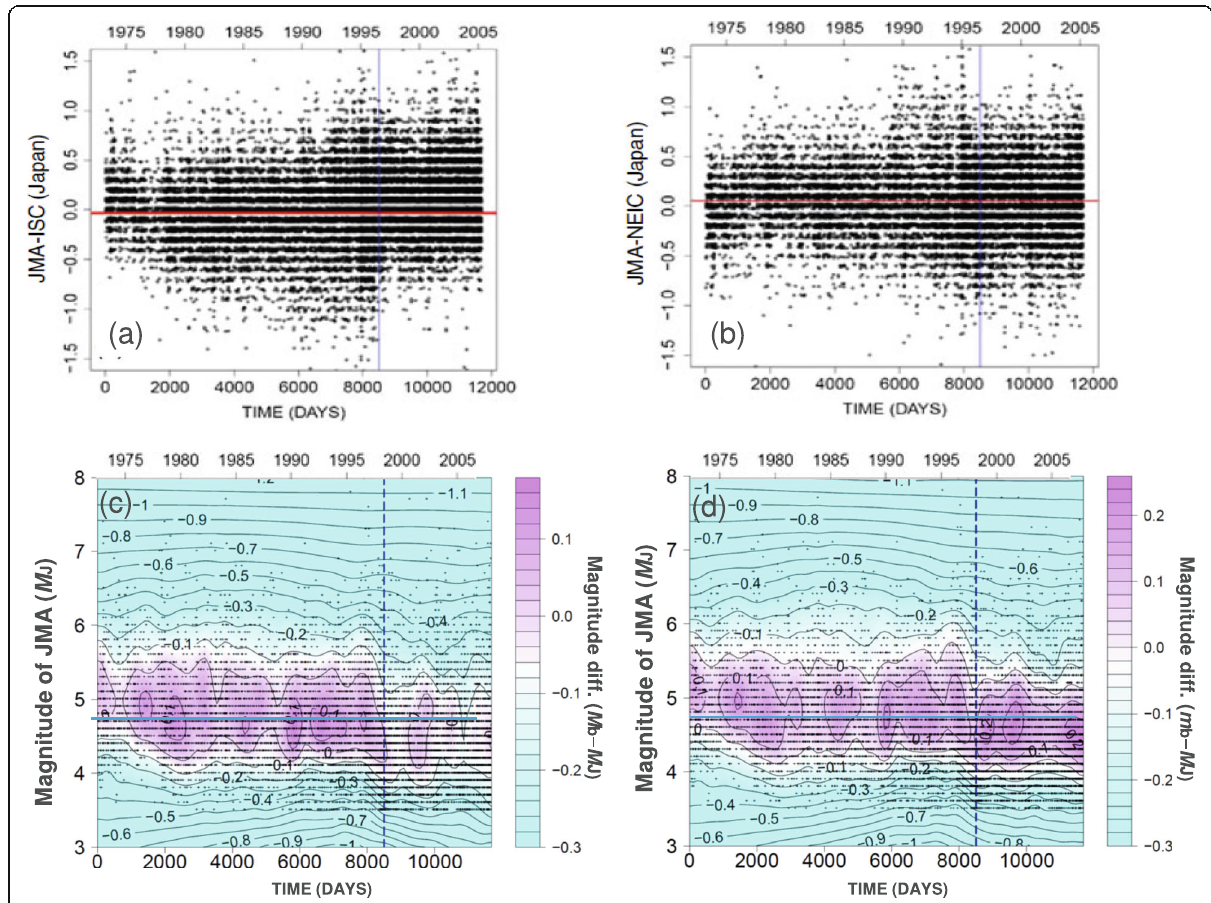
Fig. 4 Magnitude differences of ISC and USGS magnitudes against JMA magnitude M JMA in the Japan area. Magnitude differences a M JMA – M b , b M JMA – m b of the same earthquakes in ISC body wave magnitude M b and USGS body wave magnitude m b , respectively, relative to the JMA magnitude (1973 – 2005), c smoothed surfaces of M b – M JMA on the plane of M JMA , d shows the same as c , replacing M b with m b . Contours show an equidistance of 0.1 magnitude unit differences of the smoothed surface, and higher magnitudes differences are shown in purple (in contrast to light blue). The vertical solid lines in a – d show changes of the magnitude difference pattern in the range where plots were highly